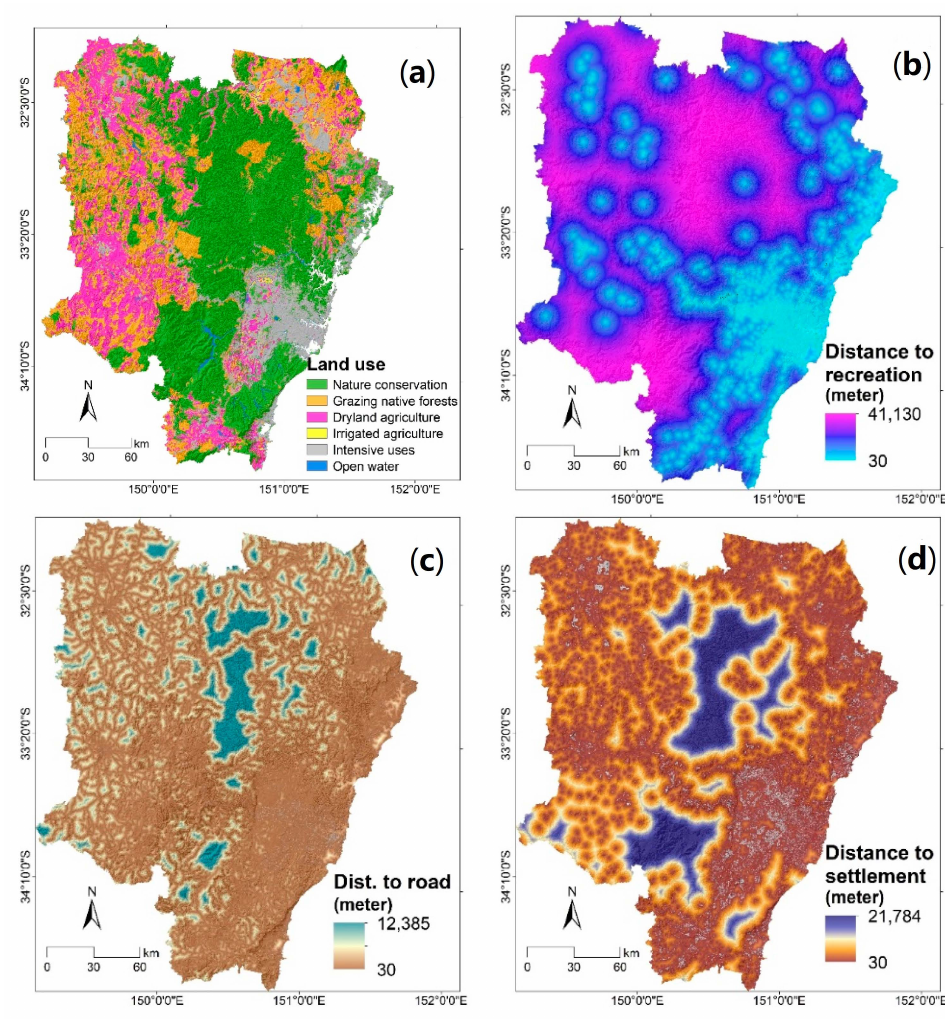
Figure 6. Anthropological-related factors: ( a ) land use, ( b ) distance to recreational areas, ( c ) distance to roads, and ( d ) distances to